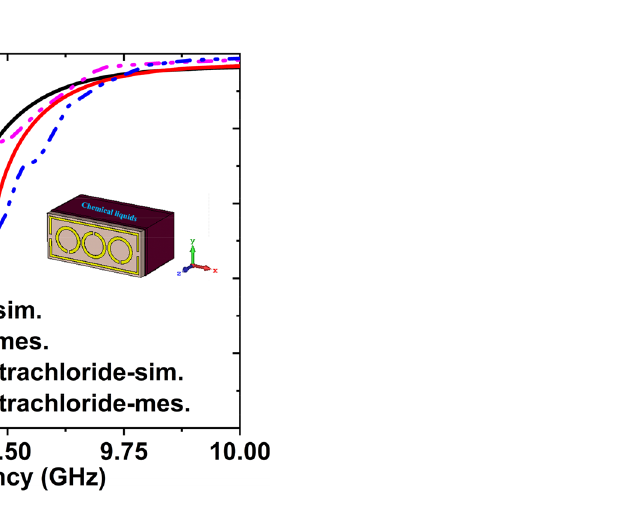
Figure 25. S 11 results for benzene, and carbon